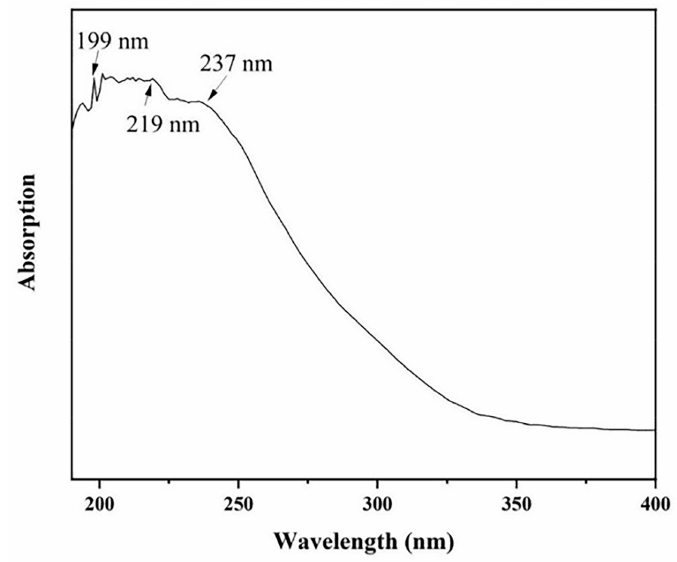
Figure 7. The absorption spectrum of AlN